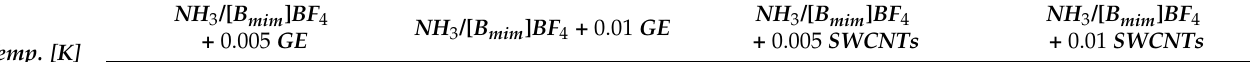
Table 6. Reduction in specific heat.